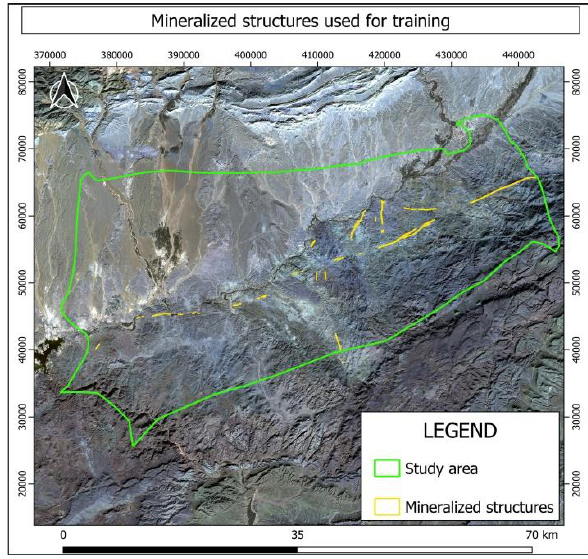
Figure 5: Slope map of the study area. The slope value at each pixel was used as the labeled data for the models. The minimal values are 0% and the maximal values are 70, 3%.